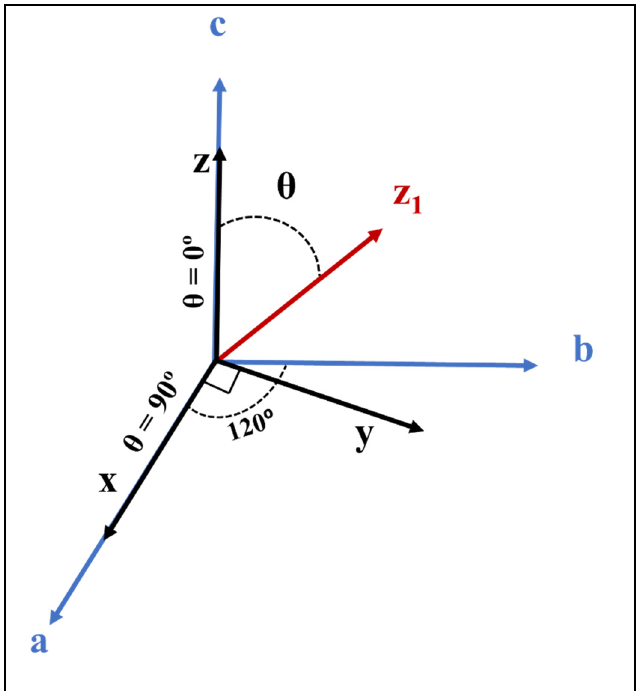
Figure 6. The hexagonal unit cell a, b, and c-axes, the orthogonal x, y, and z-axes, and the vector (z 1 ) and its direction ( θ ) with respect to the z-axis (c-axis). θ = 0° when z 1 is parallel to the z-axis (c-axis), and θ = 90° when z 1 is perpendicular to the z-axis (c-axis).